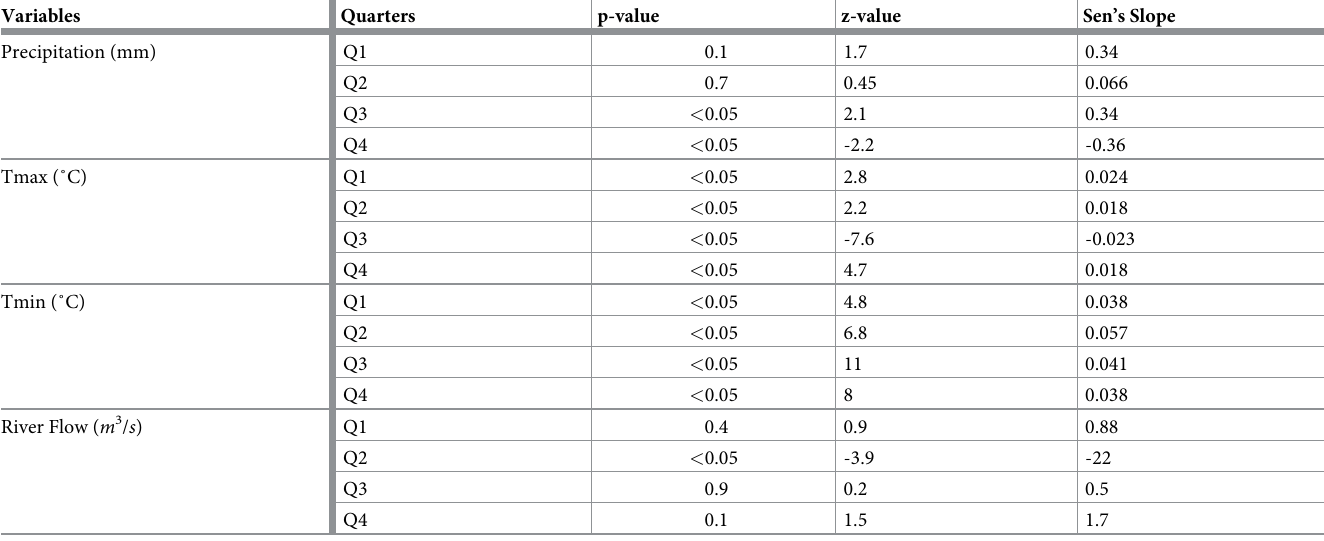
Table 4. Seasonal Mann-Kendall trend statistics calculated from spatially averaged data of precipitation, maximum temperature (Tmax) and minimum temperature (Tmin) over the whole UJRB and river flow in four quarters (Q1, Q2, Q3 and Q4) during 1982 to 2015.